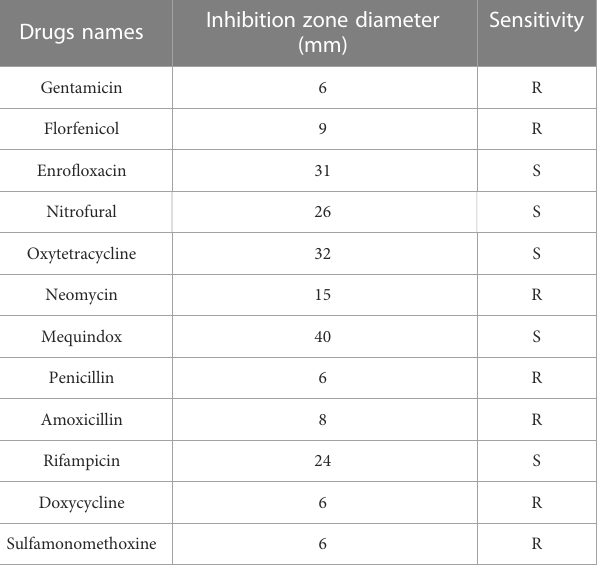
TABLE 3 Drug sensitivity test results of NFEM01 strain.